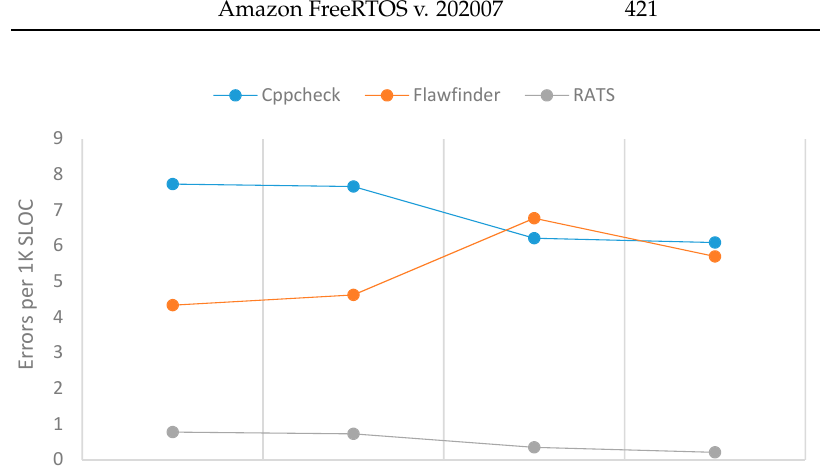
Figure 6. Errors per 1 K SLOC of FreeRTOS.